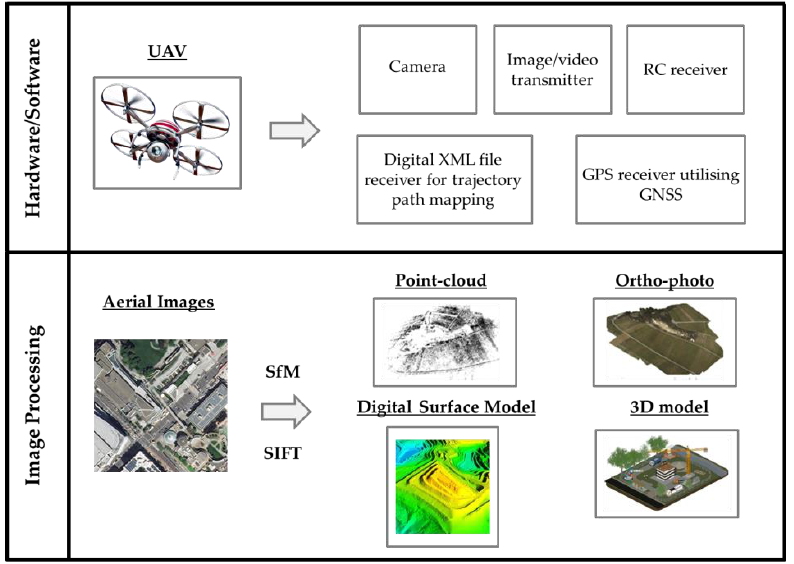
Figure 2. Components of the UAV system.